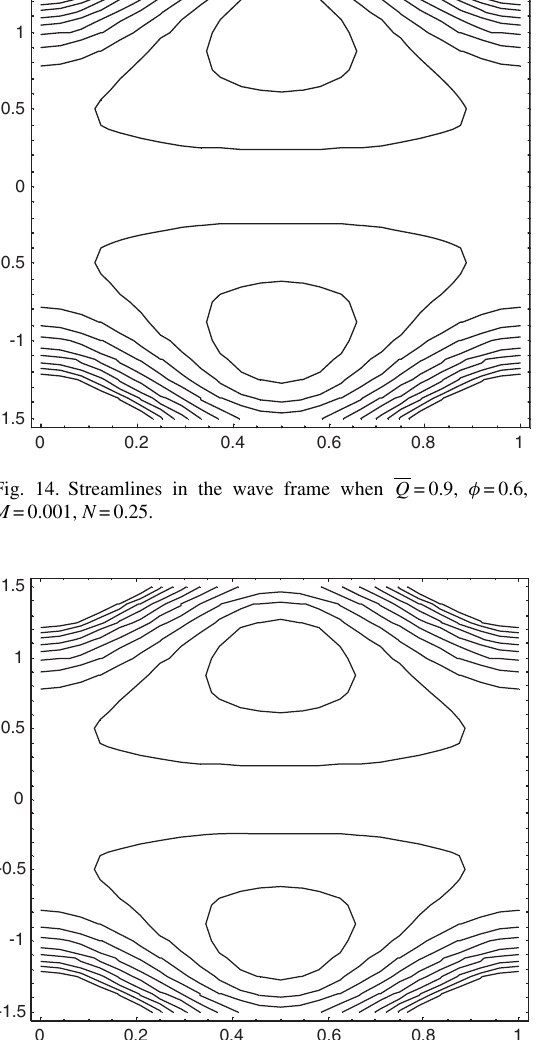
high flow rates and when occlusions are very large (cf. [21]). The trapped region moves with the wave- velocity. It has been studied for varying micro-polar parameter M and coupling number N . We plot stream- lines based on Eq. (38) for this case. Illustrating Figs (14–17) reveal that when M is increased by keeping other parameters unchanged, the size of the trapped region decreases slightly. Unlike this, the size of the trapped region increases when N enhances with